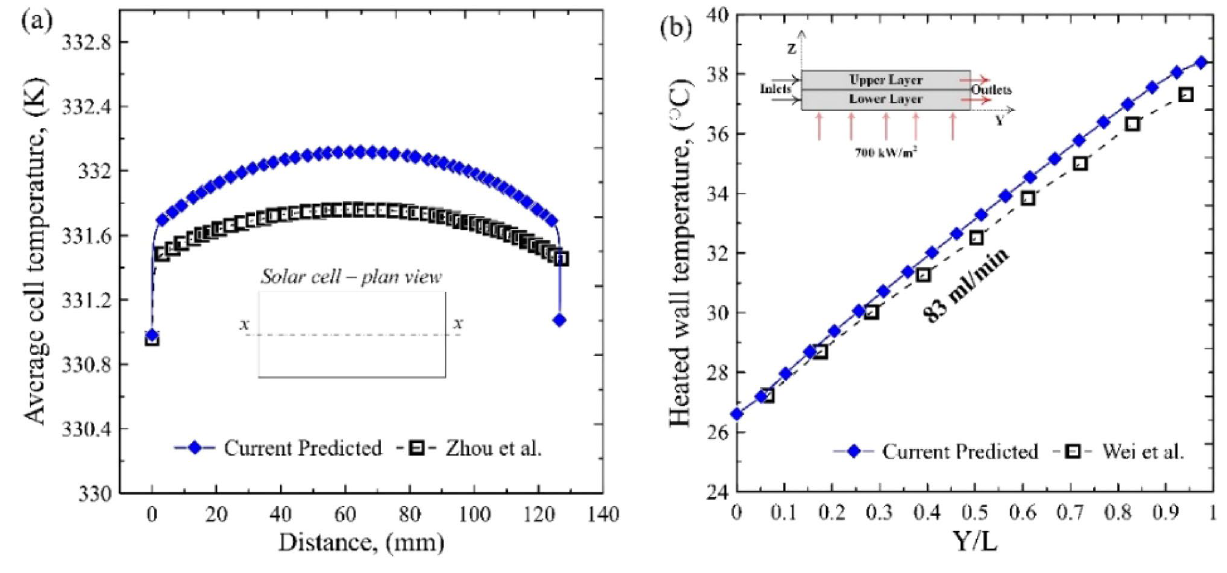
Figure 5. Model validation with ( a ) Zhou et al. 17 , ( b ) Wei et al. 21 .